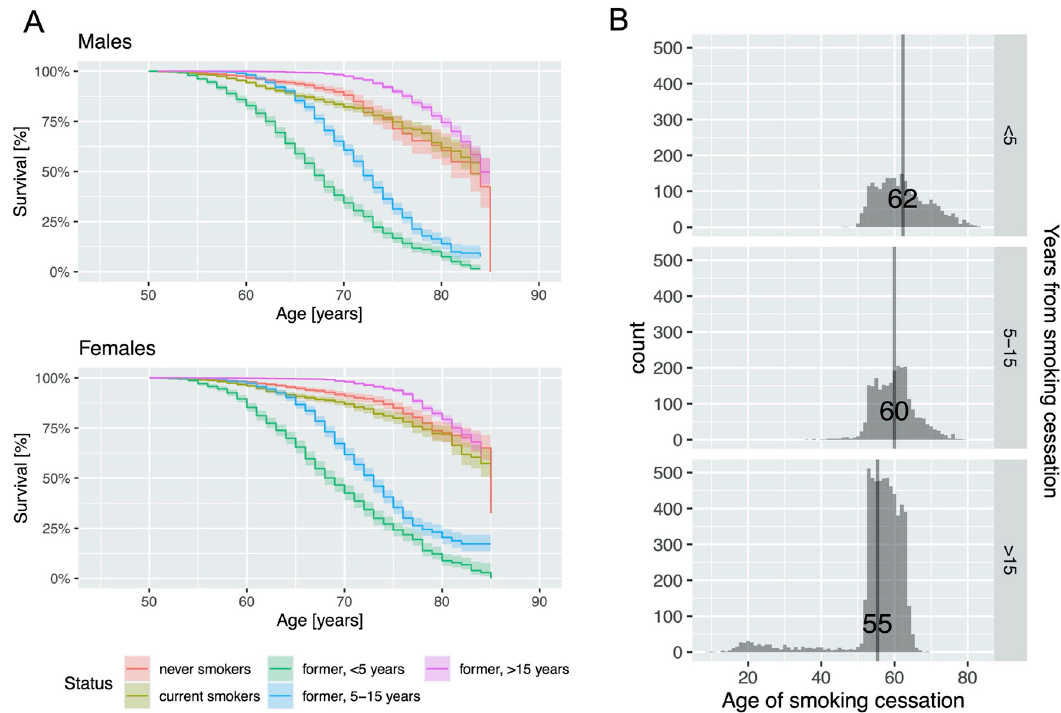
Fig 3. Smoking cessation > 15 years reduced the hazards of smoking on age of death in both men and women. A) Kaplan-Meier survival curves for all-cause mortality in men and women between 50–85 years for smoking cessation status. B) Histogram and average of age of smoking cessation in different groups of former smokers in